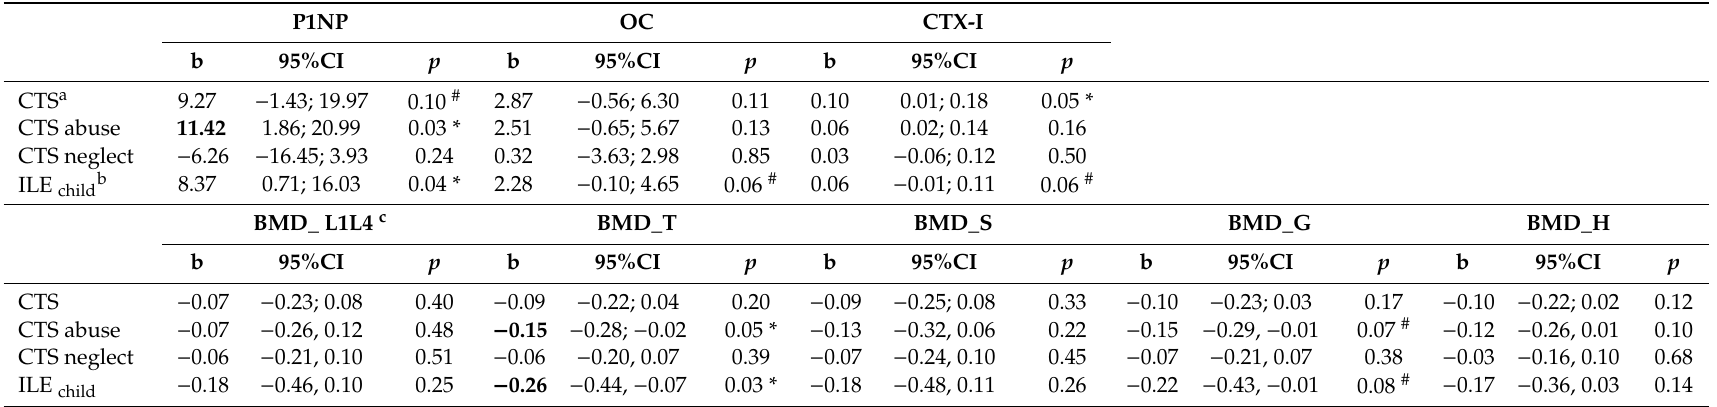
Multiple regression models, adjusted for age, gender, and study sides. Significant Regression coe ffi cients b are bold. Significance level: * p < 0.05, and # p < 0.1. a Childhood Trauma Screener (CTS) at least at risk for one type of neglect or abuse (sexual, physical, emotional abuse, physical, emotional neglect); b Inventory of Stressful Life Events; stressful life events during childhood ( ≤ 12 years); c Bone mineral density (BMD) was measured as mean value (M) in the lumbar spine L1-L4 (lumbar vertebralis bodies), T (trochanter major), S (corpus femoris), G (total), and H (collum